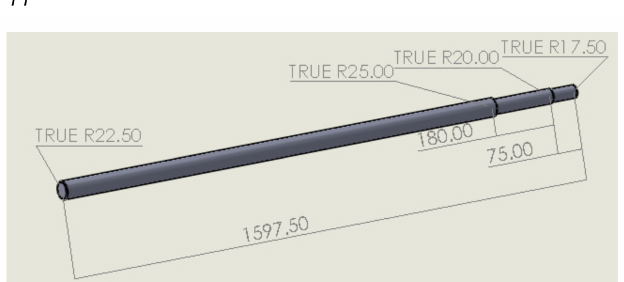
Figure A5. Threshing shaft (Dimensions in mm).